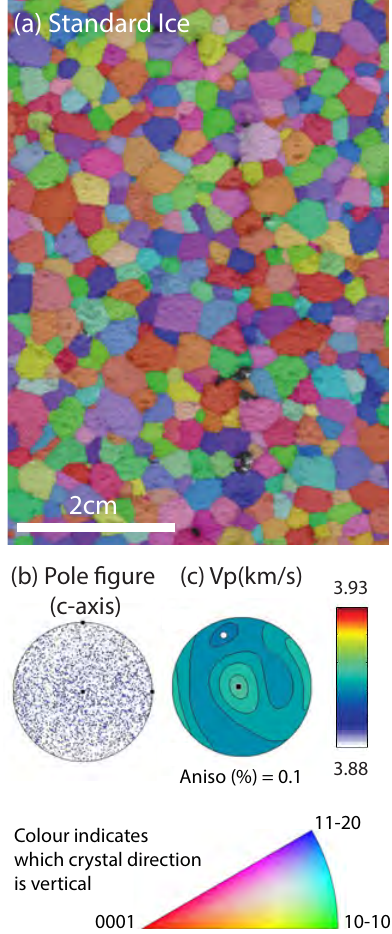
Figure 1. A subset of a large electron backscatter diffraction (EBSD) data set, from a sample of standard ice, manufactured by the same methods employed for the samples in these experiments. We acquired this map using a Zeiss Sigma VP FEGSEM fitted with an Oxford Instruments Nordlys camera and AZTEC software. Modifications required for cryo-EBSD are described in Prior et al. (2015). (a) Subsection of a large EBSD map of standard ice. The full map contains over 4000 grains. (b) C-axis pole figure in up- per hemisphere projection, indicating the orientation of the c-axis at each pixel. (c) V p model derived using a Voigt–Reuss–Hill aver- age. The magnitude of anisotropy is indicated